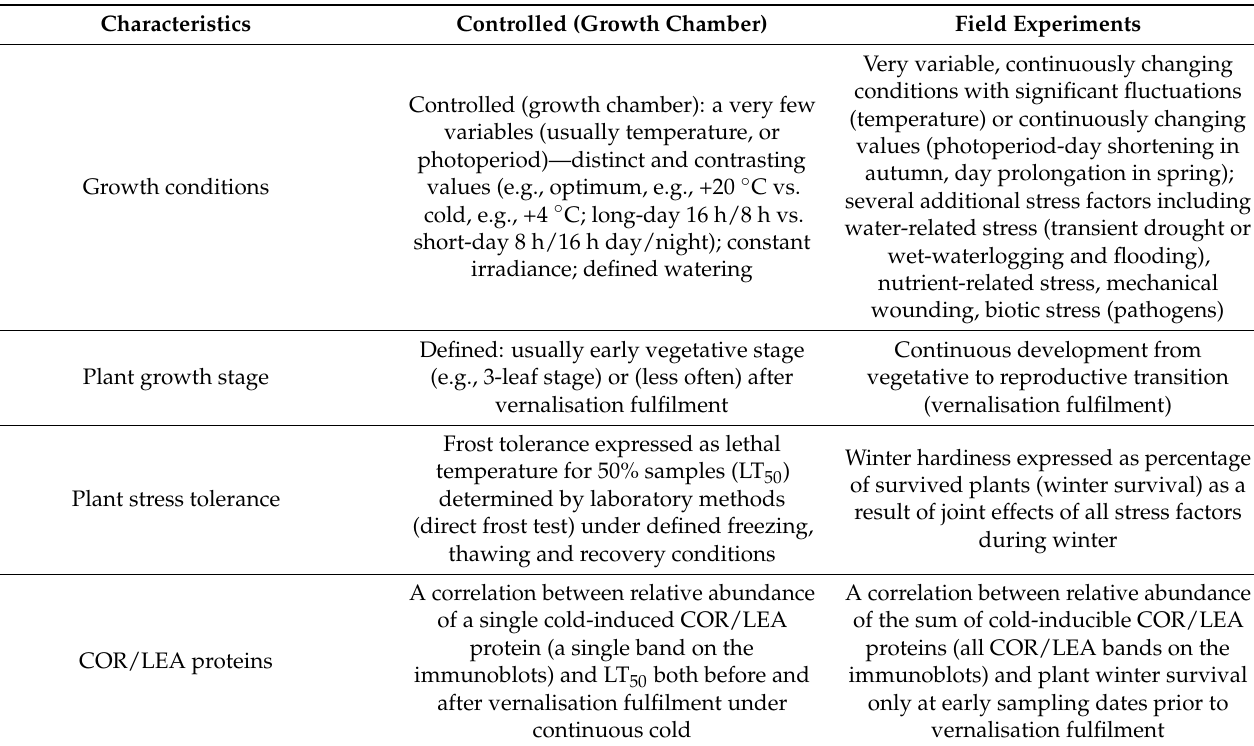
Table 2. A comparison of the impacts of controlled and field conditions on dehydrin relative accumulation and plant tolerance to